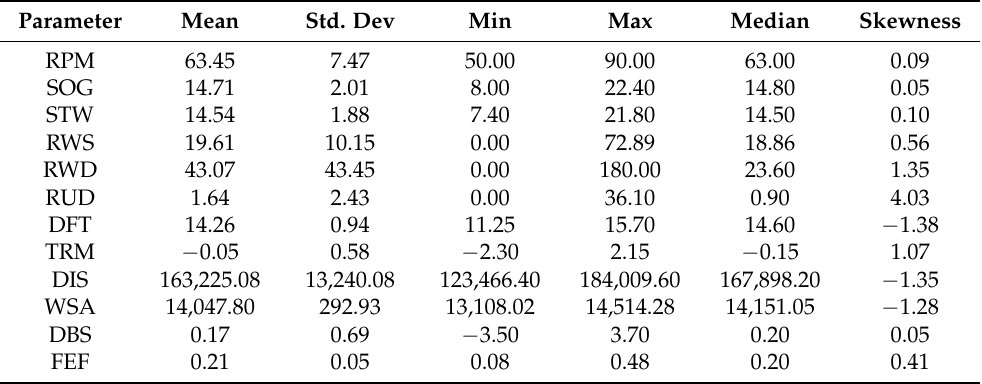
Figure 3. Time-series data filtered by median filter: ( a ) Mean draught, ( b ) Trim. Table 4. Results of statistical analysis of the input parameters after applying outlier detection and data